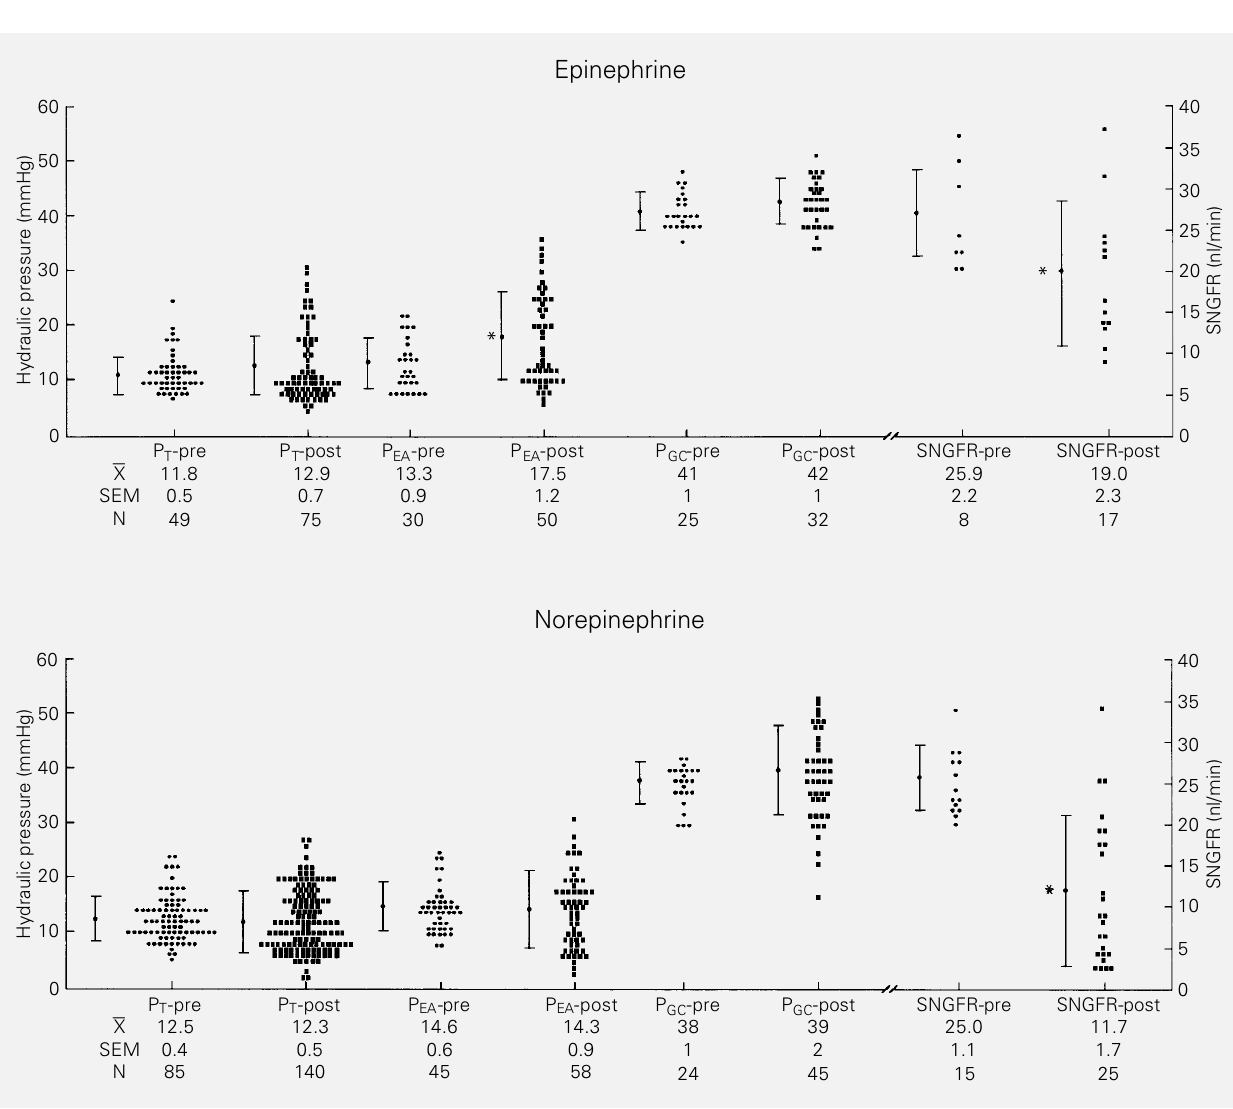
Figure 4 - Effect of epinephrine and norepinephrine on hydraulic pressures and single-nephron glomerular filtration rate (SNGFR). Hydraulic pressures (mmHg) are indicated on the left ordinate for pre- and post-epinephrine (top panel) or norepinephrine (bottom panel), where P T = tubular hydraulic pressure, P EA = efferent arteriole hydraulic pressure, and P GC = intraglomerular hydraulic pressure. SNGFR data, reported as nl/min, are indicated on the right ordinate for pre- and post-epinephrine (top panel) or norepinephrine (bottom panel). Data are reported as means – SEM for N measurements and are presented below each column. *P<0.05 vs pre (Student t